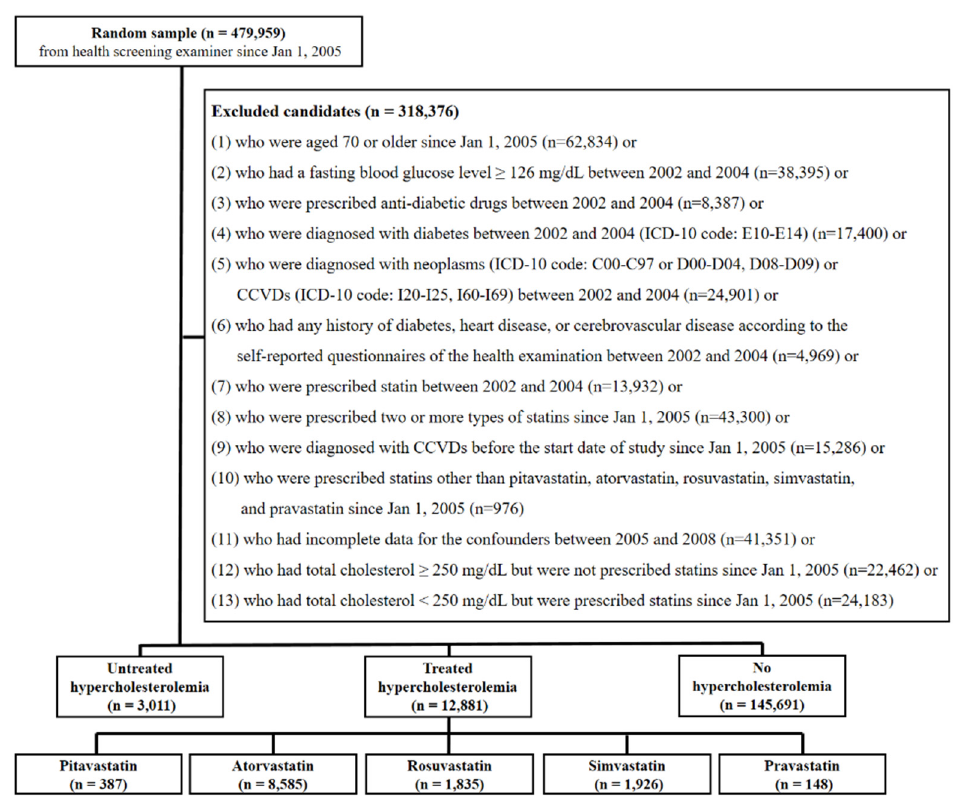
Figure 1. Flowchart of inclusion and exclusion criteria.